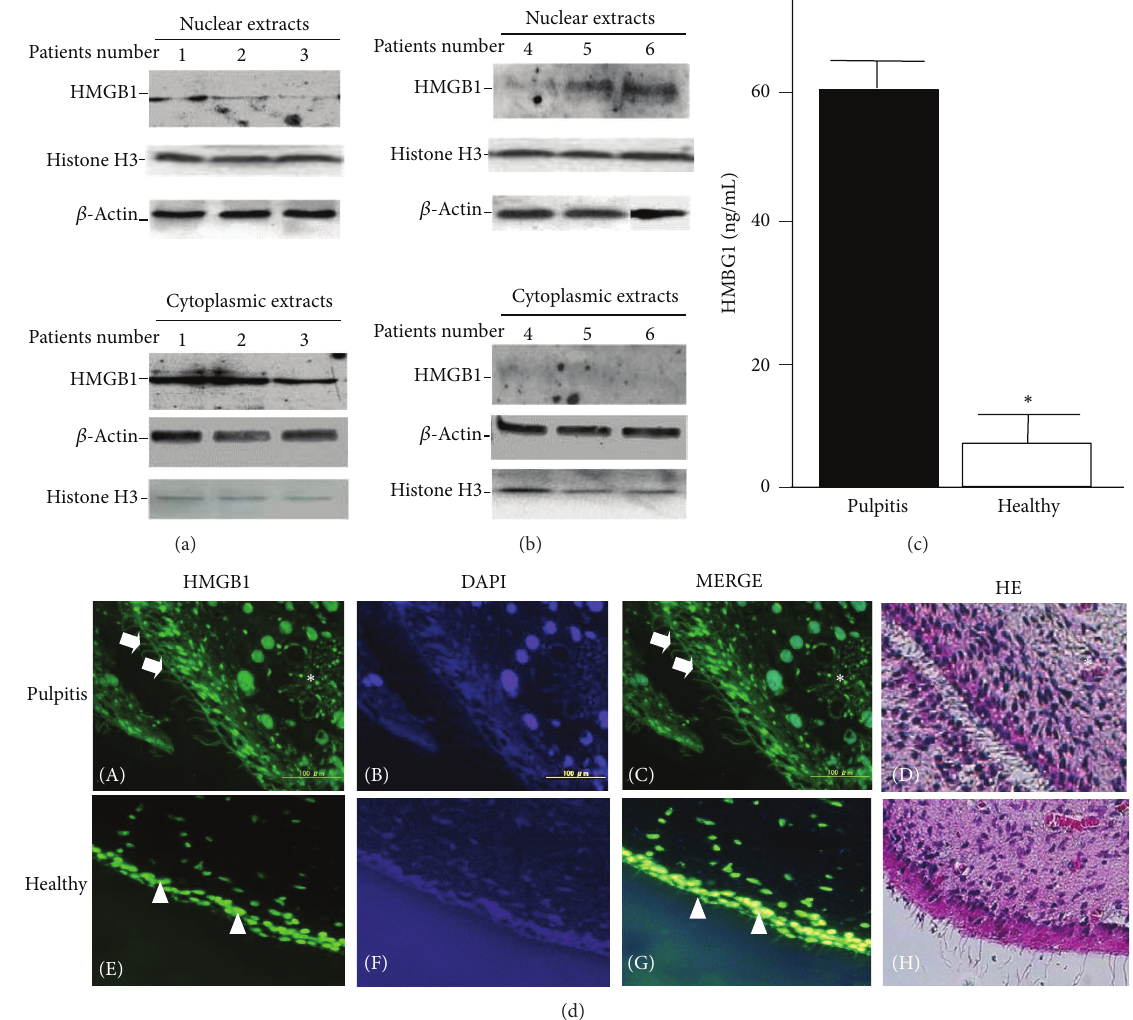
Figure 2: HMGB1 protein expression in the cytoplasmic extracts of human pulpitis tissues. Nuclear and cytoplasmic extracts from (a) pulpitis and (b) healthy tissues were determined by western blot analysis ( 𝑛 = 3 ). Histone and 𝛽 -actin were used as loading controls for nuclear and cytoplasmic extracts. Note that HMGB1 translocates to the cytoplasmic fraction in the inflamed pulp tissues. (c) HMGB1 levels in the cytosolic fraction from both tissues were determined by ELISA. Results are expressed as the means ± SD from duplicate experiments. ∗ 𝑃 < 0.001 . (d) Immunofluorescence microscopy showing the localization of cytoplasmic HMGB1 in the odontoblasts (white arrow) of pulpitis tissues. HMGB1 immunoreactivity was also seen in stromal pulp fibroblasts-like cells and endothelial-like cell lining ( ∗ ) in pulpitis tissues. HMGB1 was located in the nuclei of the odontoblasts (arrowhead) in healthy tissues. Blue depicts the nucleus stained with DAPI and green depicts the localization of HMGB1. Counterstaining was performed in Mayer’s hematoxylin (D and H). Scale bar: 100 𝜇